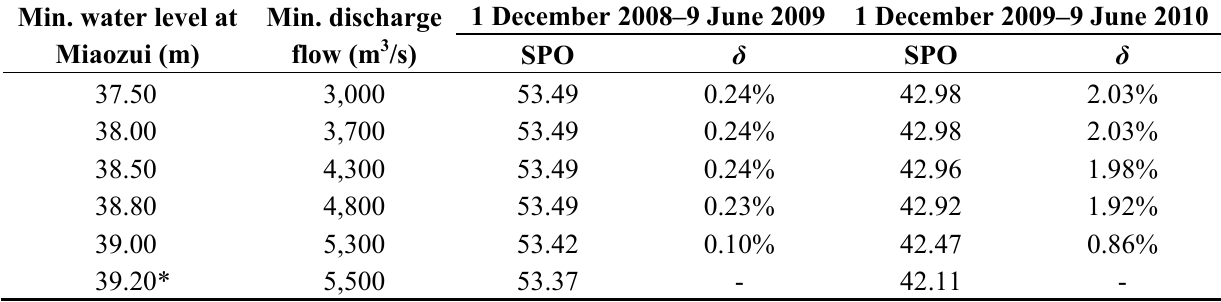
Table 6. Impact of lowering minimum navigation water level on power generation during Min. water level at